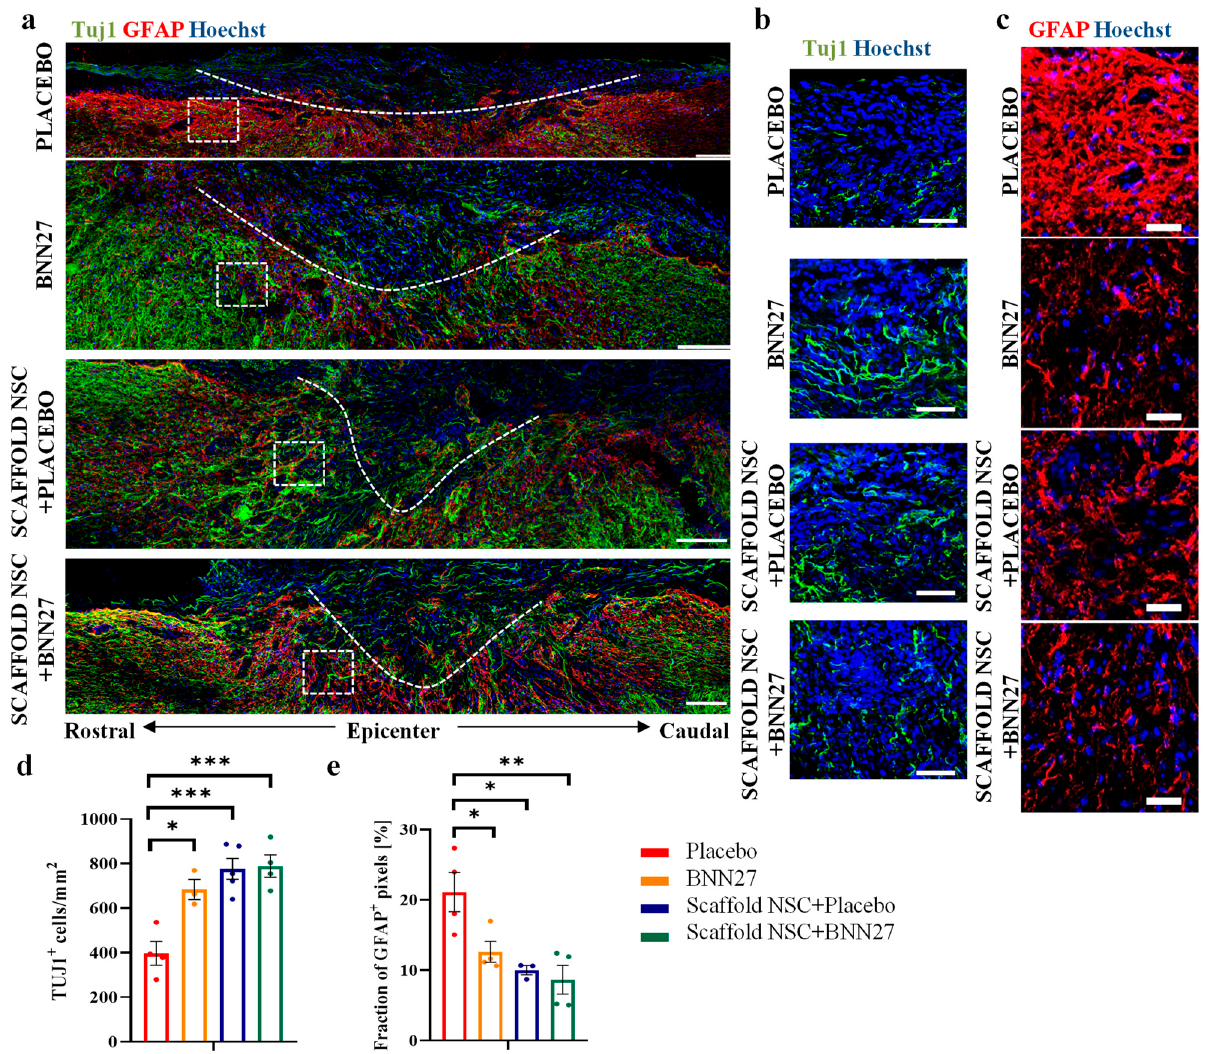
Figure 2. Effects of NSC-seeded PCS grafts and BNN27 administration on neuronal density and astrogliosis. ( a ) Representative fluorescence images of spinal cord parasagittal sections from all four injured groups immunostained for Tuj1 (green) and GFAP (red). The boundaries of lesion site (epicenter) are marked with a dotted line. Scale bars: 100 μ m. ( b ) High-magnification fluorescence images in the lesion epicenter of image ( a ) visualizing Tuj1 immunostaining. Scale bars: 30 μ m. ( c ) High-magnification fluorescence images of the rectangular ROI shown in image ( a ) showing GFAP immunostaining at the lesion boundary region. Scale bars: 30 μ m. ( d ) Quantification of the density of Tuj1 + cells within the lesion epicenter at 12 wpi in the four injured animal groups (“Placebo”: n = 4, “BNN27”: n = 3, “Scaffold NSC + Placebo”: n = 5, “Scaffold NSC + BNN27” n = 4). ( e ) Quantification of the fraction of GFAP + pixels (marker of astrogliosis) in the lesion boundary region at 12 wpi in the four injured animal groups (“Placebo”: n = 4, “BNN27”: n = 4, “Scaffold NSC + Placebo”: n = 3, “Scaffold NSC + BNN27” n = 4). Results are presented as mean ± SEM. * p < 0.05, ** p < 0.01, *** p < 0.001; Tukey’s post hoc pairwise test assuming P 2-way-ANOVA < 0.05.